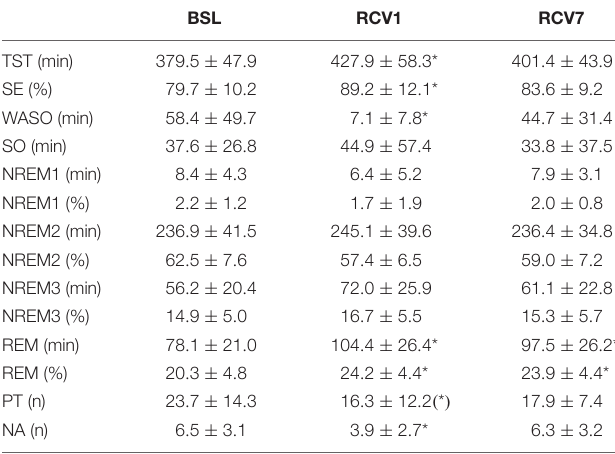
TABLE 3 | Polysomnography